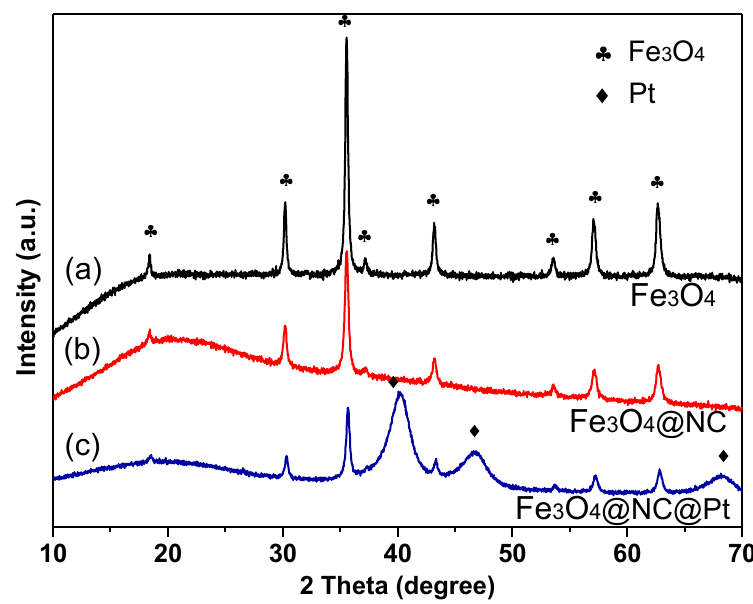
Figure 2. XRD patterns of ( a ) Fe 3 O 4 ; ( b ) Fe 3 O 4 @NC; ( c ) Fe 3 O 4 @NC@Pt. The specific surface area and pore structure of Fe 3 O 4 @NC@Pt were examined using low-temperature nitrogen adsorption – desorption measurements, the specific surface area was calculated by BET method [35], and the pore size distribution was calculated by Barrett – Joyner – Halenda (BJH) method [36]. From Figure 3, it can be seen that the isotherm of Fe 3 O 4 @NC@Pt is type IV compared with various type isotherms classified by